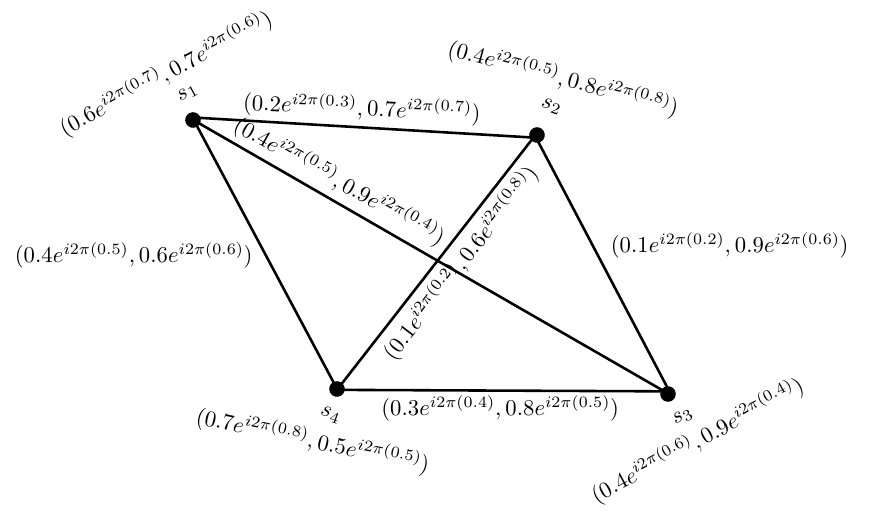
Figure 9. ( 1.0 e i 2 π ( 1.4 ) ,3.0 e i 2 π ( 2.4 ) ) -edge regular Figure 9: (1 . 0 e i 2 π (1 . 4) , 3 . 0 e i 2 π (2 . 4) )-edge regular CPFG.